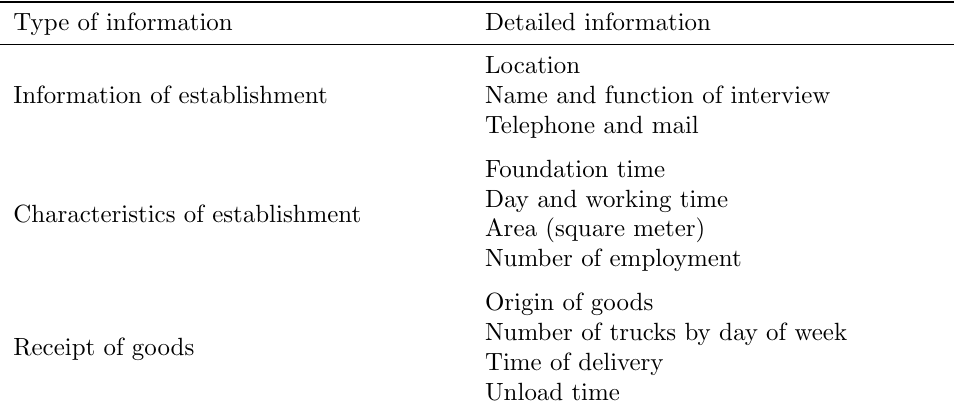
Table 2: Main information of